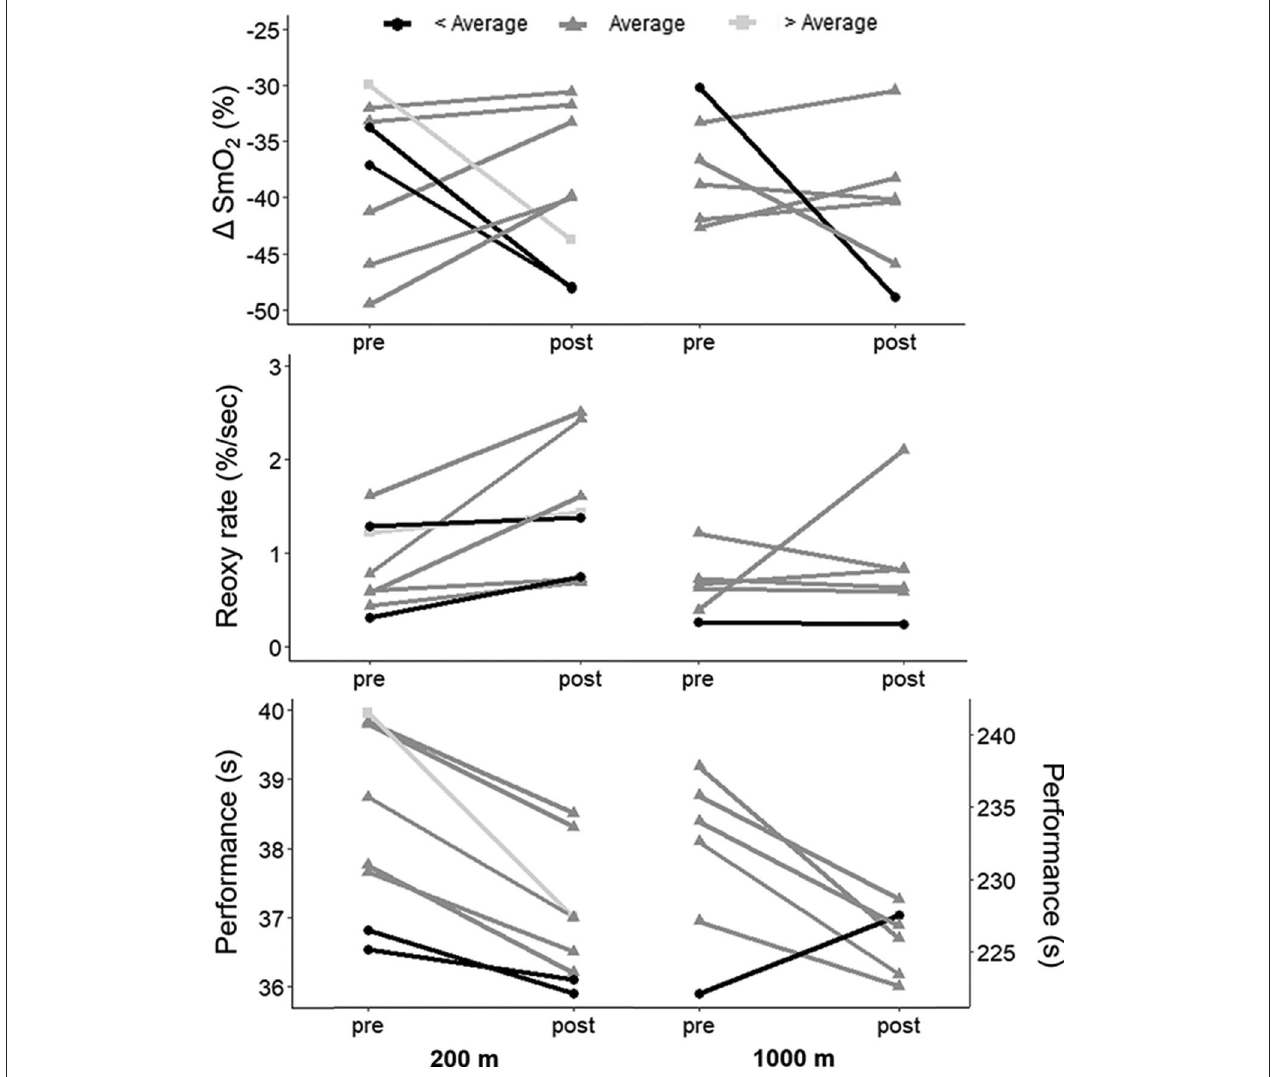
FIGURE 2 | Individual changes in performance, 1 SmO 2 and reoxy rate in the 200-m and 1,000-m TT with the 3-weeks training camp. Subjects were grouped according to their change in performance, compared to the rest of the group. < Average: subjects whose performance improved by less than (group mean − 0.5*group standard deviation); Average: subjects whose performance improved between (group mean − 0.5*group standard deviation) and (group mean + 0.5*group standard deviation); > Average: subjects whose performance improved by more than (group mean + 0.5*group standard deviation).